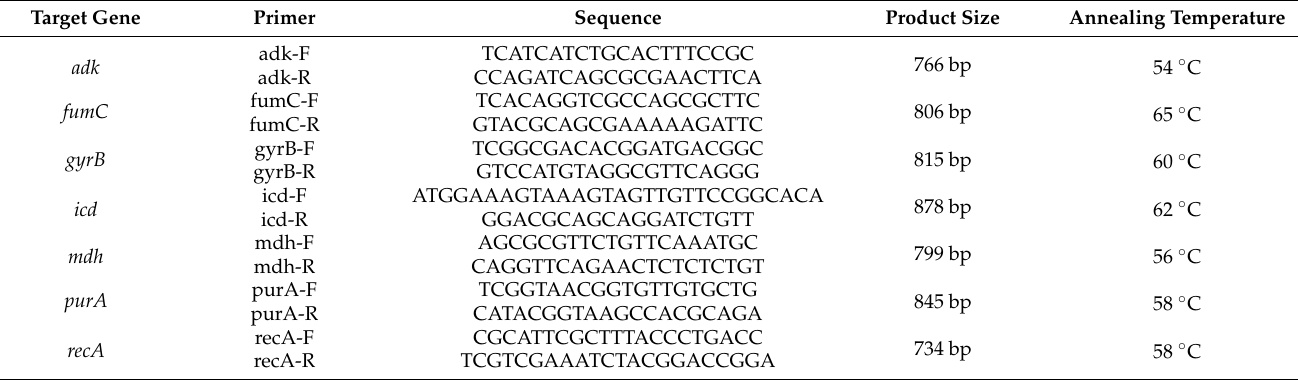
Table 1. Primer and the annealing temperature settings for MLST analysis (adapted from [31]). Target